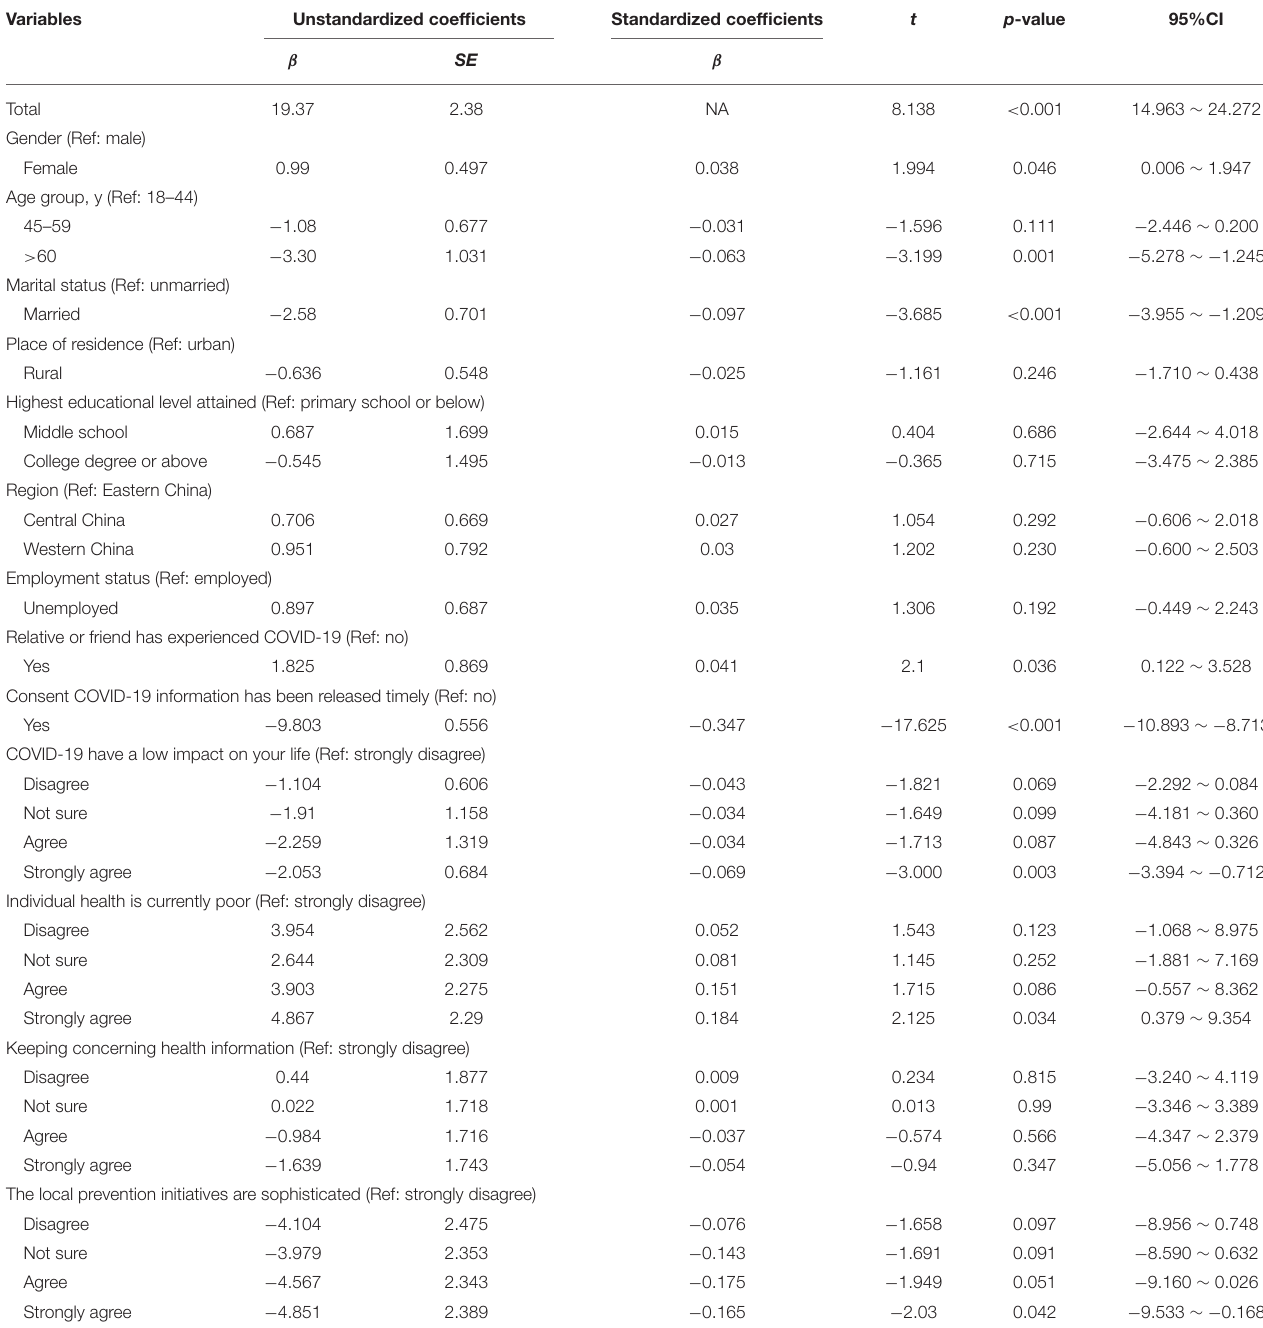
TABLE 2 | Stepwise regression analysis of associated factors for PTSD among respondents.